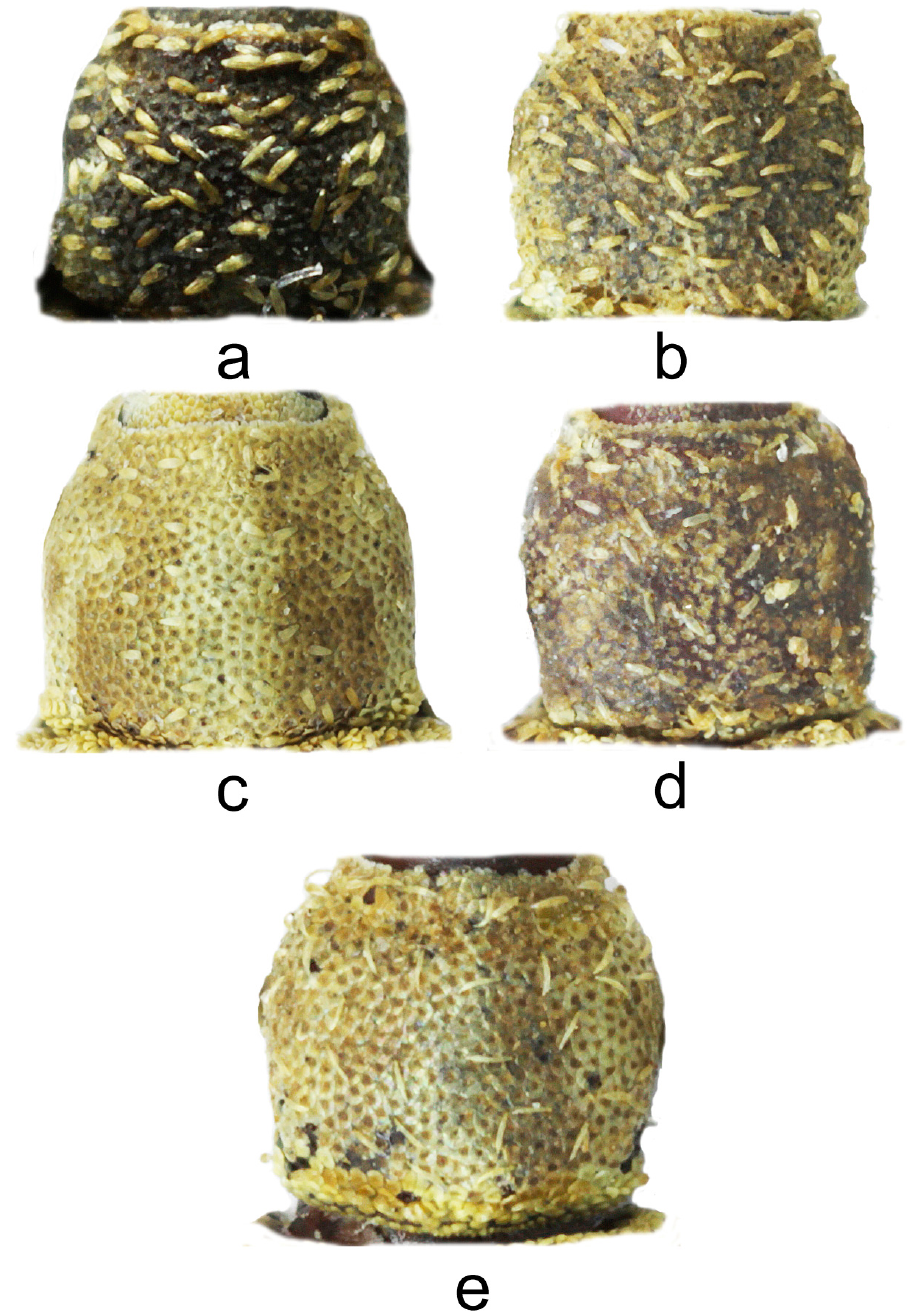
Figure 2. Scales on pronotum of ( a ) Afroryzophilus djibai ; ( b ) A. centrafricanus ; ( c ) A. kuscheli ; ( d ) A. congoanus ; ( e ) A. somalicus . (Not at the same scale).